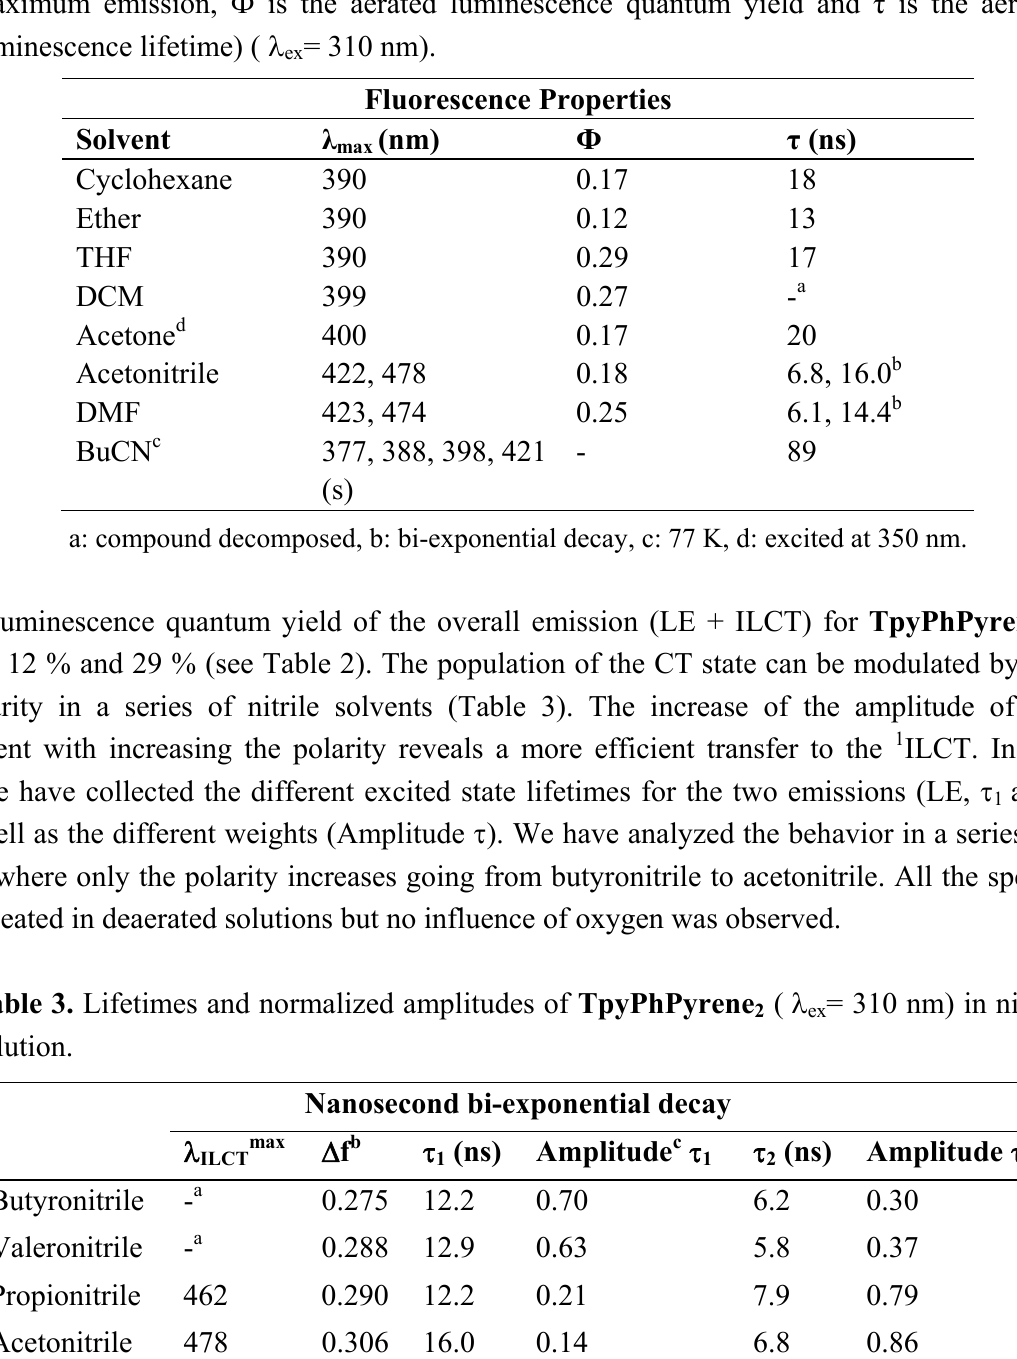
in different solvents ( λ 2